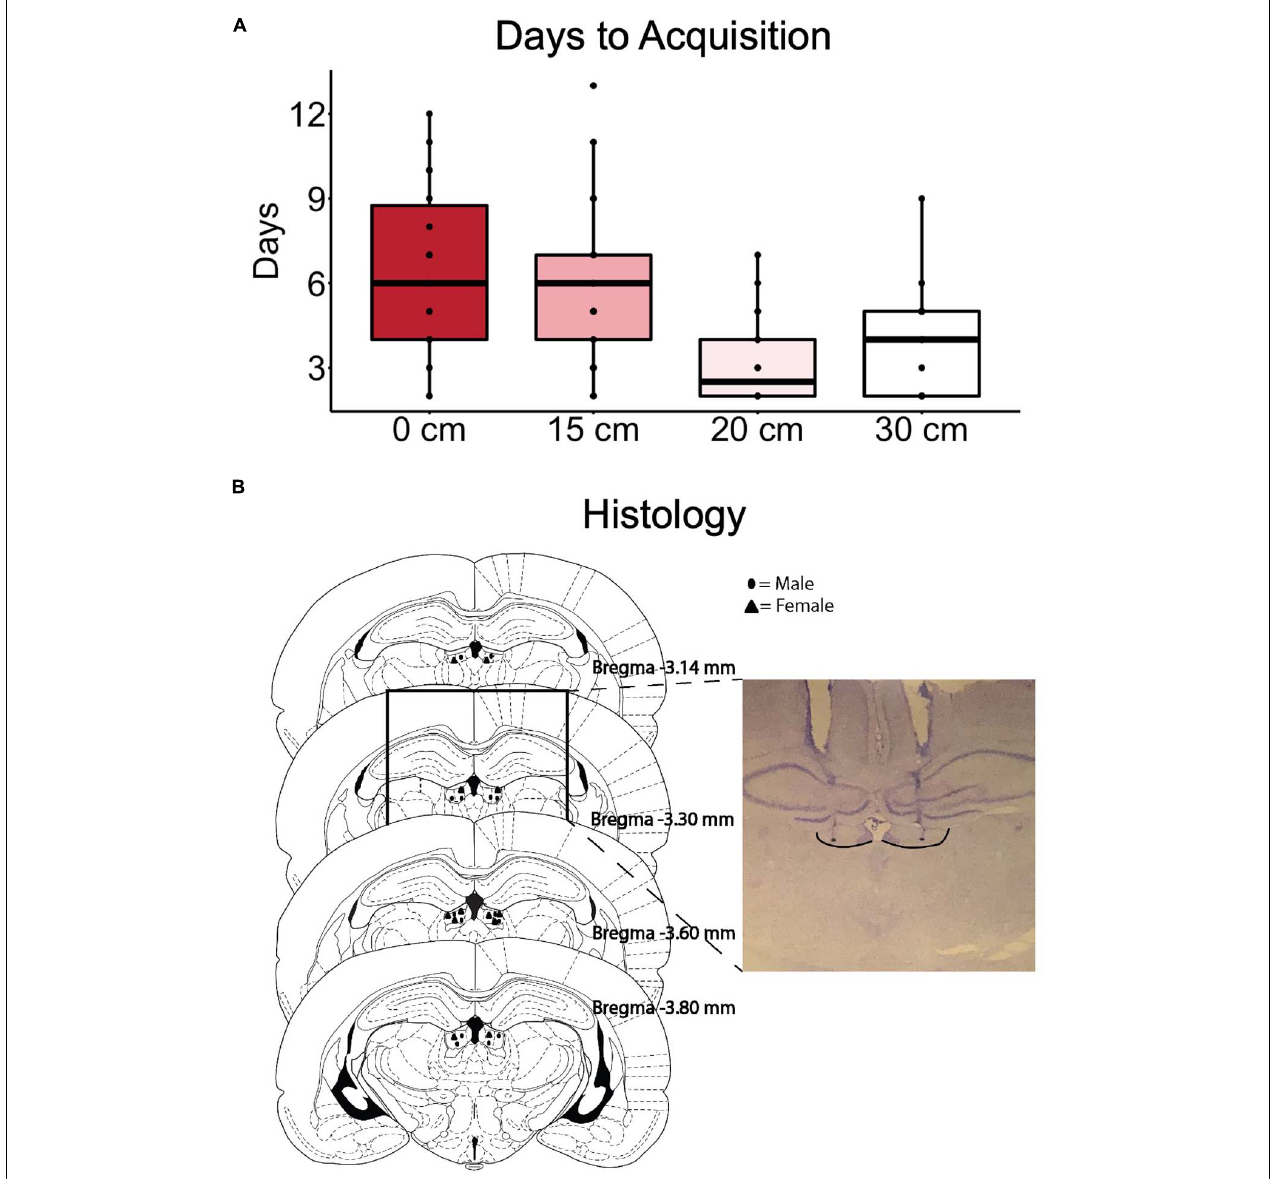
FIGURE 2 | The number of days required to reach criteria (high reward choices ≥ 80) at each training stage is indicated in (A) . (B) Summary of correct cannula placements in the LHb with an inset example of a successful placement of cannula aimed at the LHb. Borders of LHb added and (*)’s indicate internal cannula